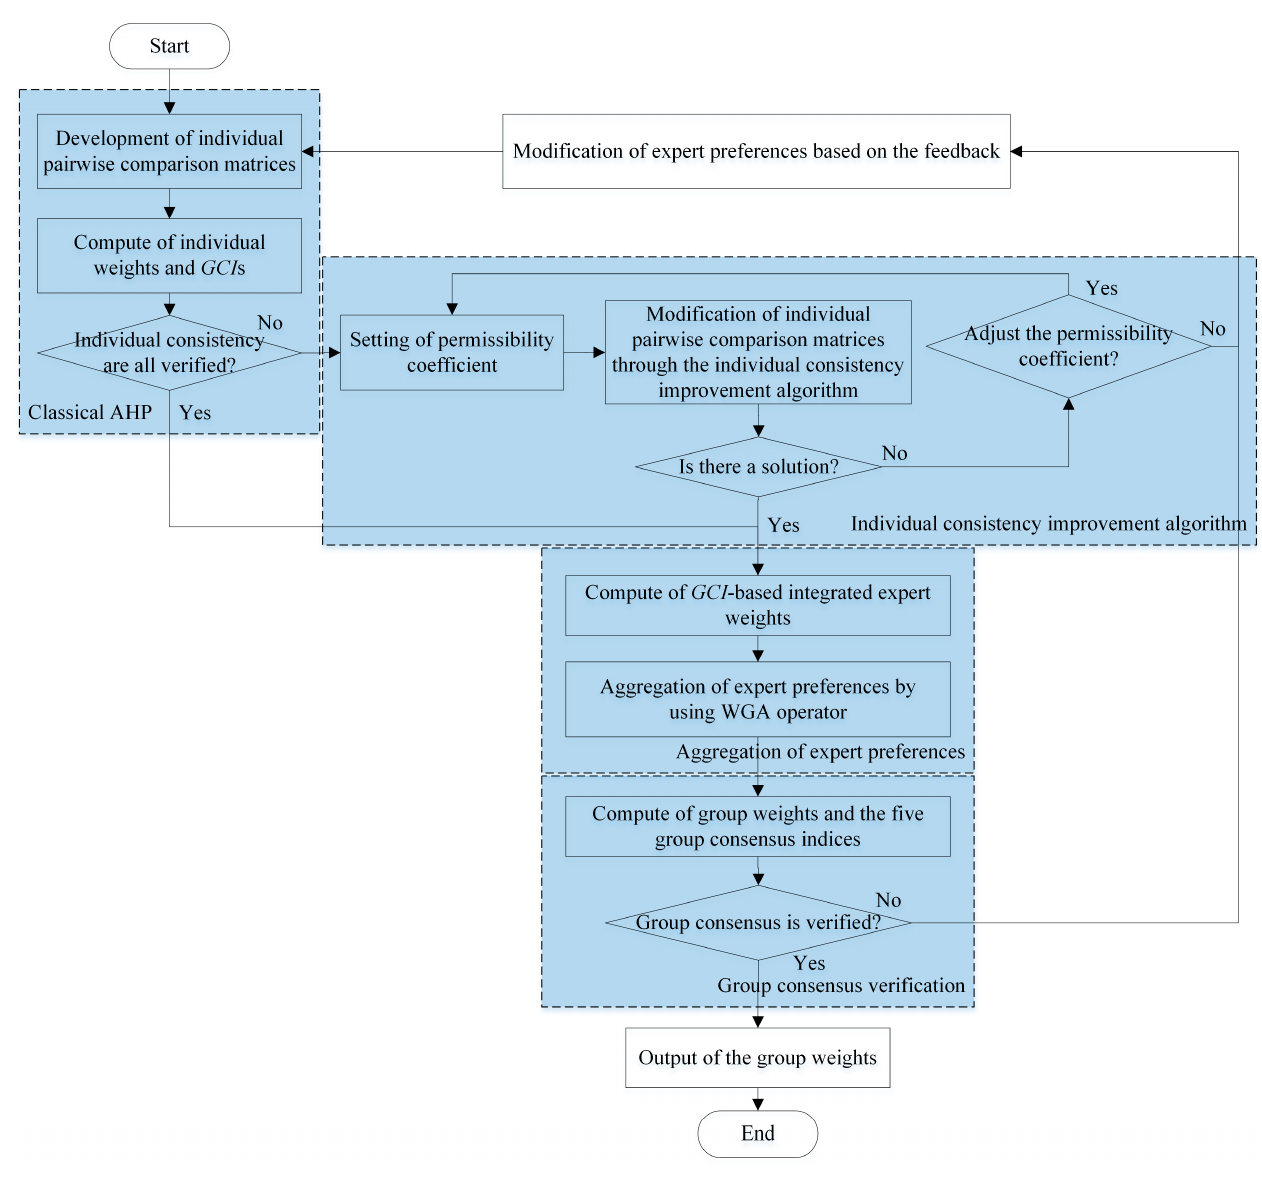
Figure 5. Flow chart of the improved AHP technique.